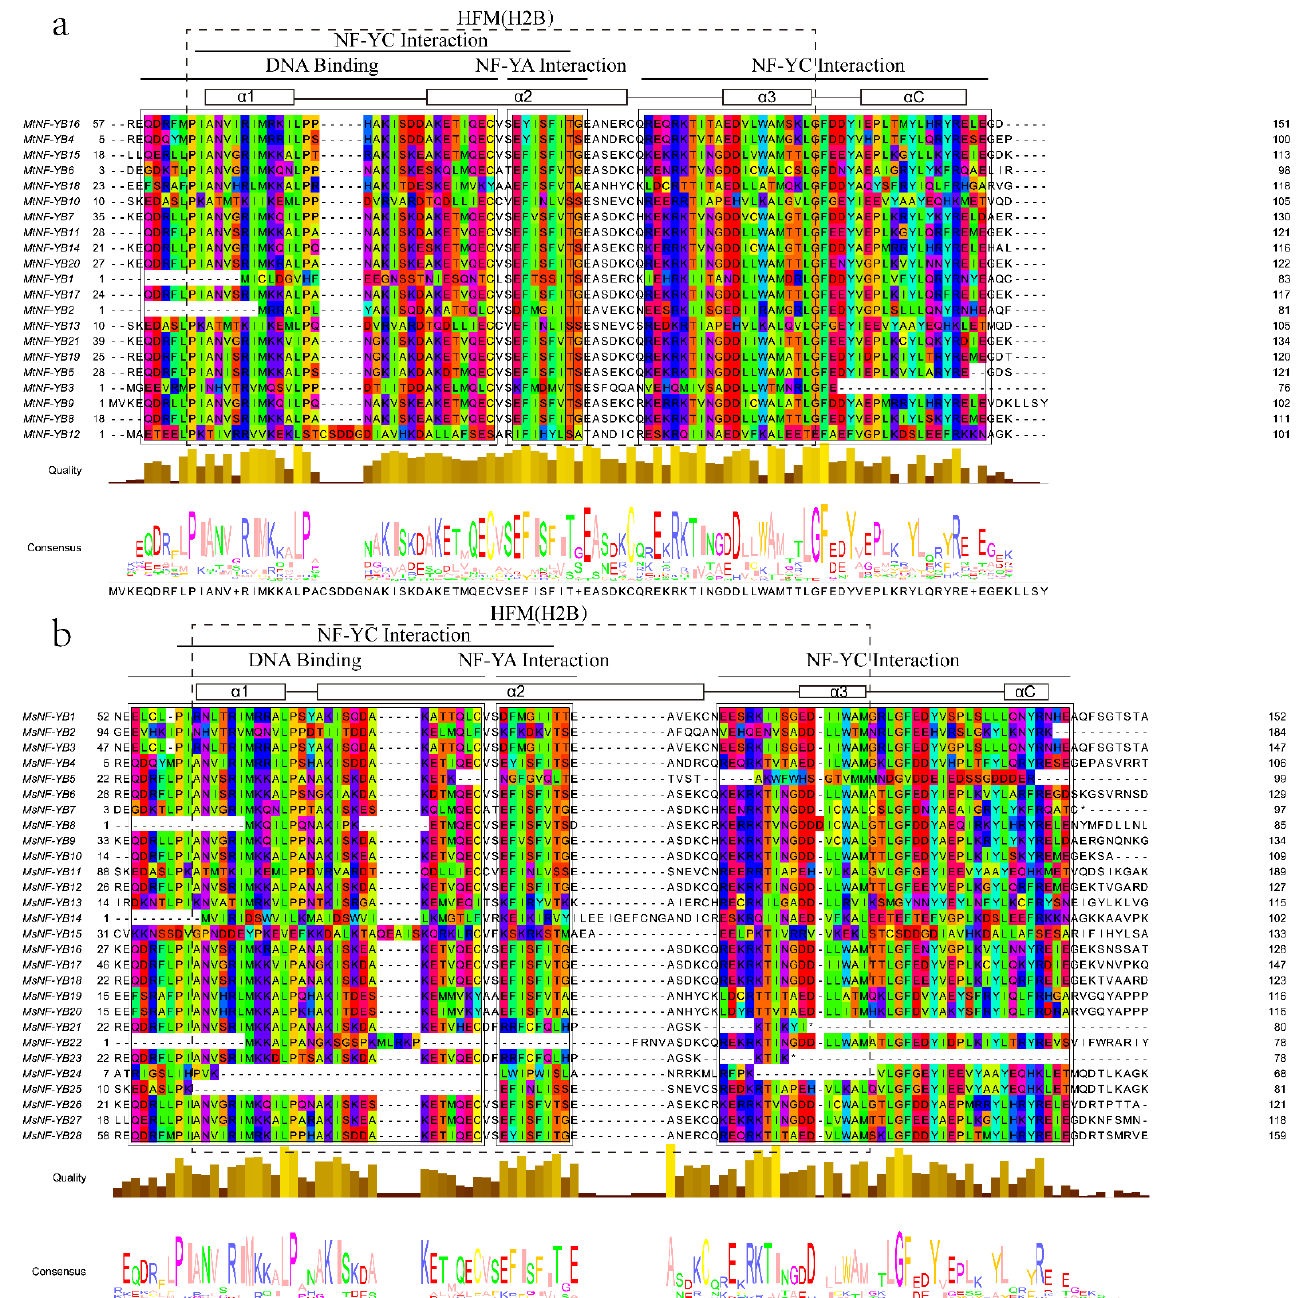
Figure 1. Multiple sequence alignment of MtNF-YBs and MsNF-YBs. The figure only showed partial sequences containing α 1, α 2, α 3, and α C domains. The alignment was constructed by MEGA-X and visualized by Jalview. Residues with more than 50% similarity are shaded. Conserved regions (DNA binding, NF-YA interaction, and NF-YC interaction) are indicated at the top. ( a ) Multiple sequence alignment of NF-YB from M. truncatula . ( b ) Multiple sequence alignment of NF-YB from M. sativa .